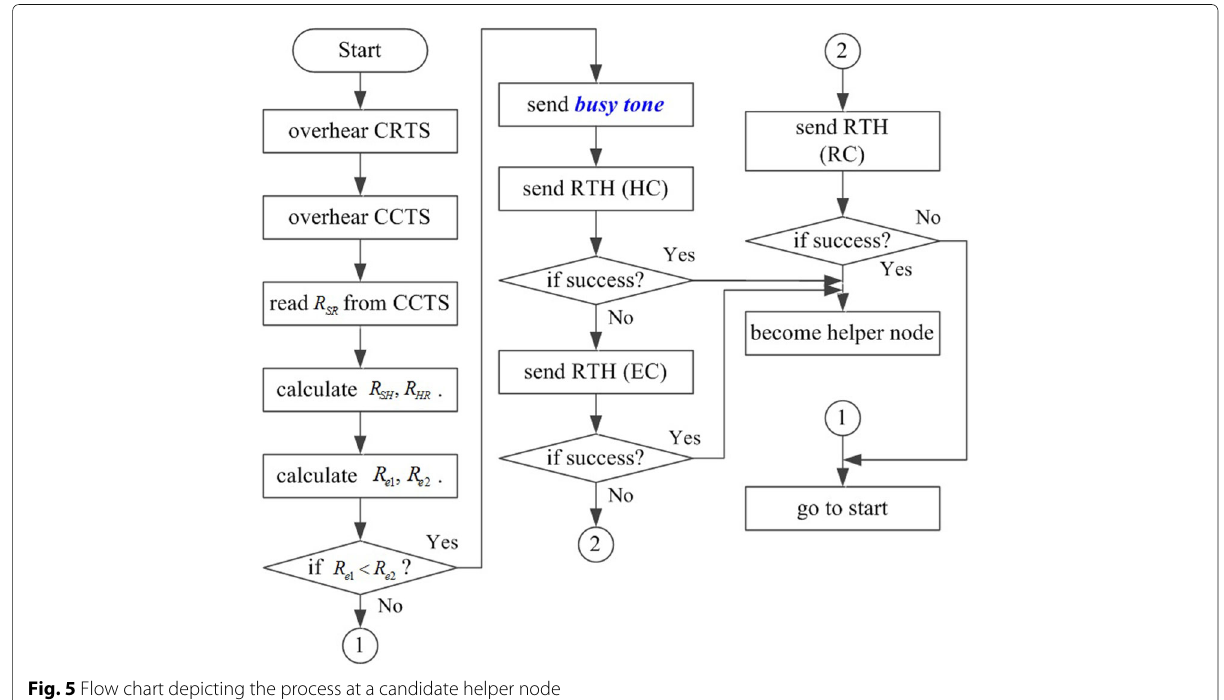
Fig. 5 Flow chart depicting the process at a candidate helper node As described in Section 2, the helper node selection scheme consists of three steps: HC, EC, and RC competi- tions. The probability of successful helper node selection in each step is provided in Lemma 2.